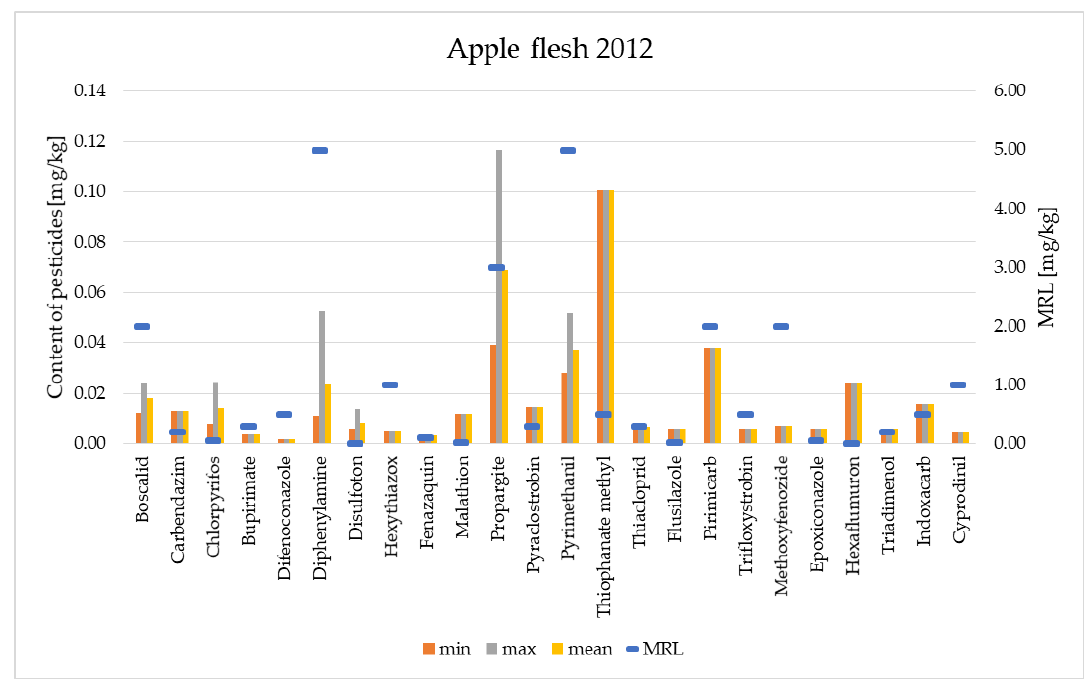
Figure 8. Content of pesticides in samples of peels of apples from the harvest of 2020.